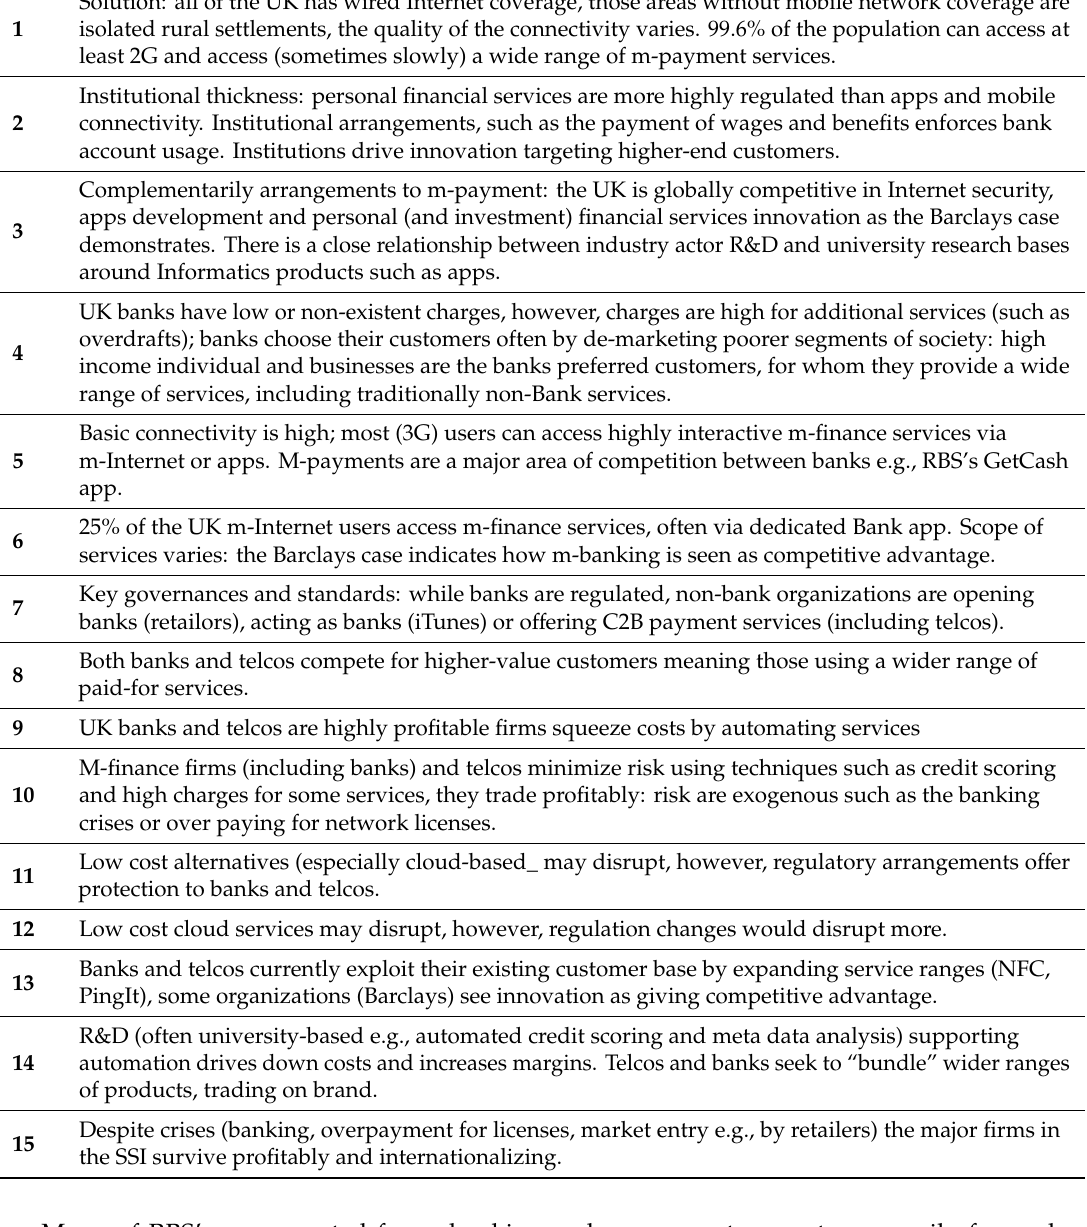
Table 2. Key parameters of the UK m-payments